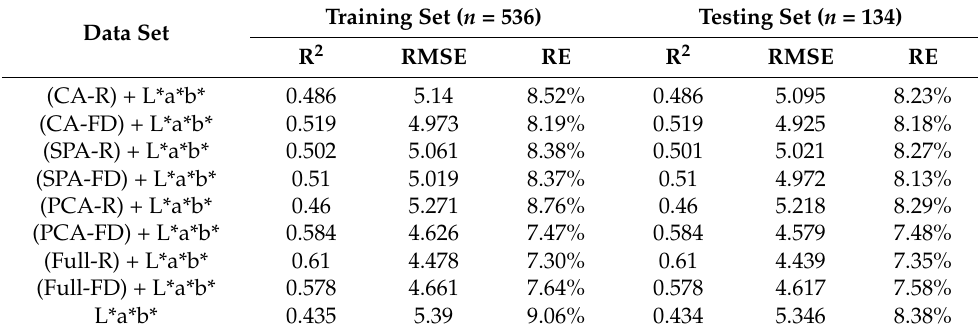
Table 3. Results of the RFR models based on spectrum and L*a*b* characteristics data set. Data